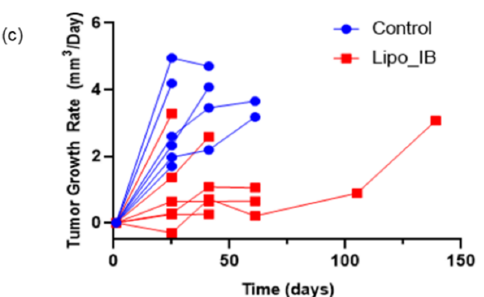
Figure 5. Lipo-IB treatment leads to tumor regression and significantly delays tumor progression in SmoA1 mouse. Representative results from a single mouse. ( a ) MRI scan of a tumor bearing mouse (tumor circled) at the start of the study (12 weeks old, Day 1) demonstrating typical tumor progression by serial MRI until sacrifice at Day 61 due to tumor burden. ( b ) MRI scan of a tumor bearing mouse treated with Lipo-IB. White arrows at Days 1 and 25 show reduction in tumor volume following Lipo-IB treatment. Arrow at 105 shows recurrence of tumor after discontinuation of Lipo-IB treatment. ( c ) Measurement days of tumor growth rate (GR) over time. GR = 0 represent non-growth tumor, GR < 0 represent tumor regression, GR > 0 represent tumor growth and more rapidly growing tumors have higher GR values (black arrow indicate Lipo-IB treatment start).